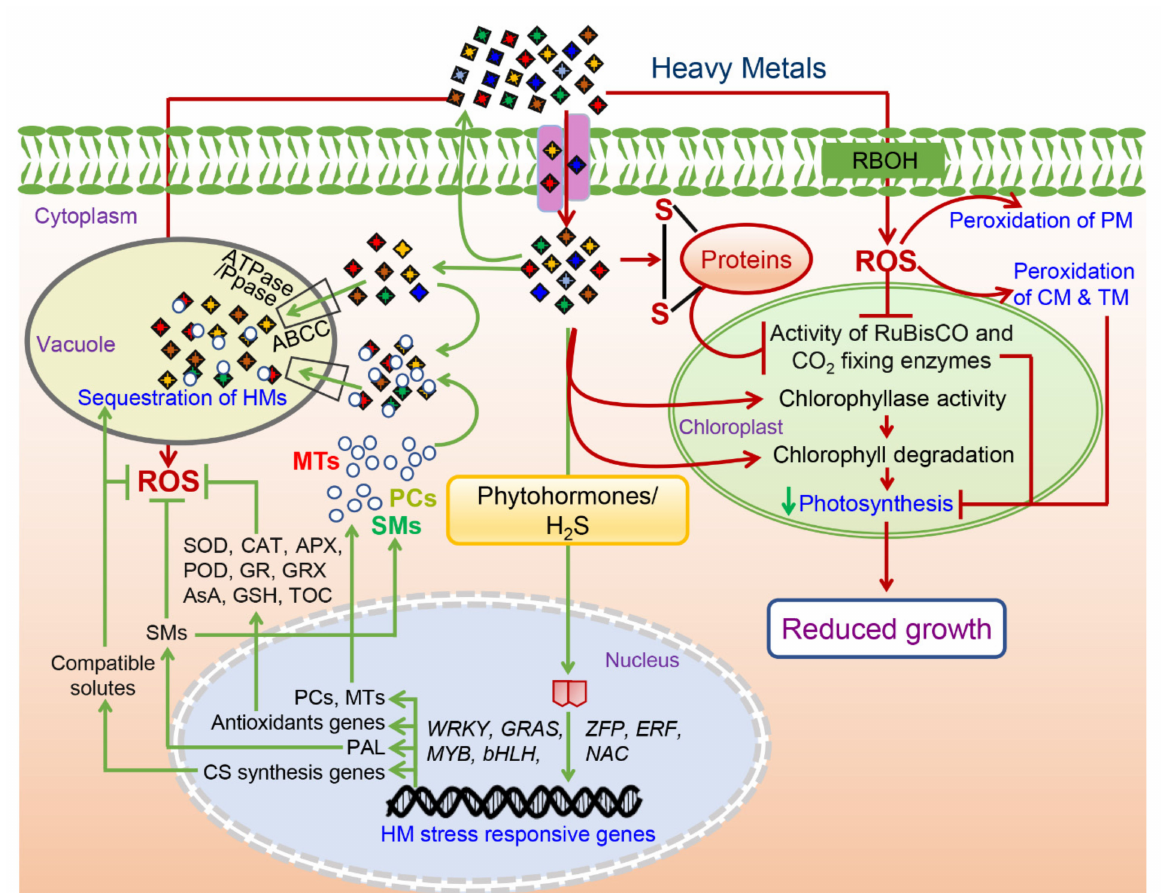
Figure 2. A putative diagram showing positive and positive molecular responses of the heavy metals (HM) toxicity in the plants. Responses marked with the red color represent negative effects of the HM toxicity while those marked with the green color represent tolerance response to alleviate the